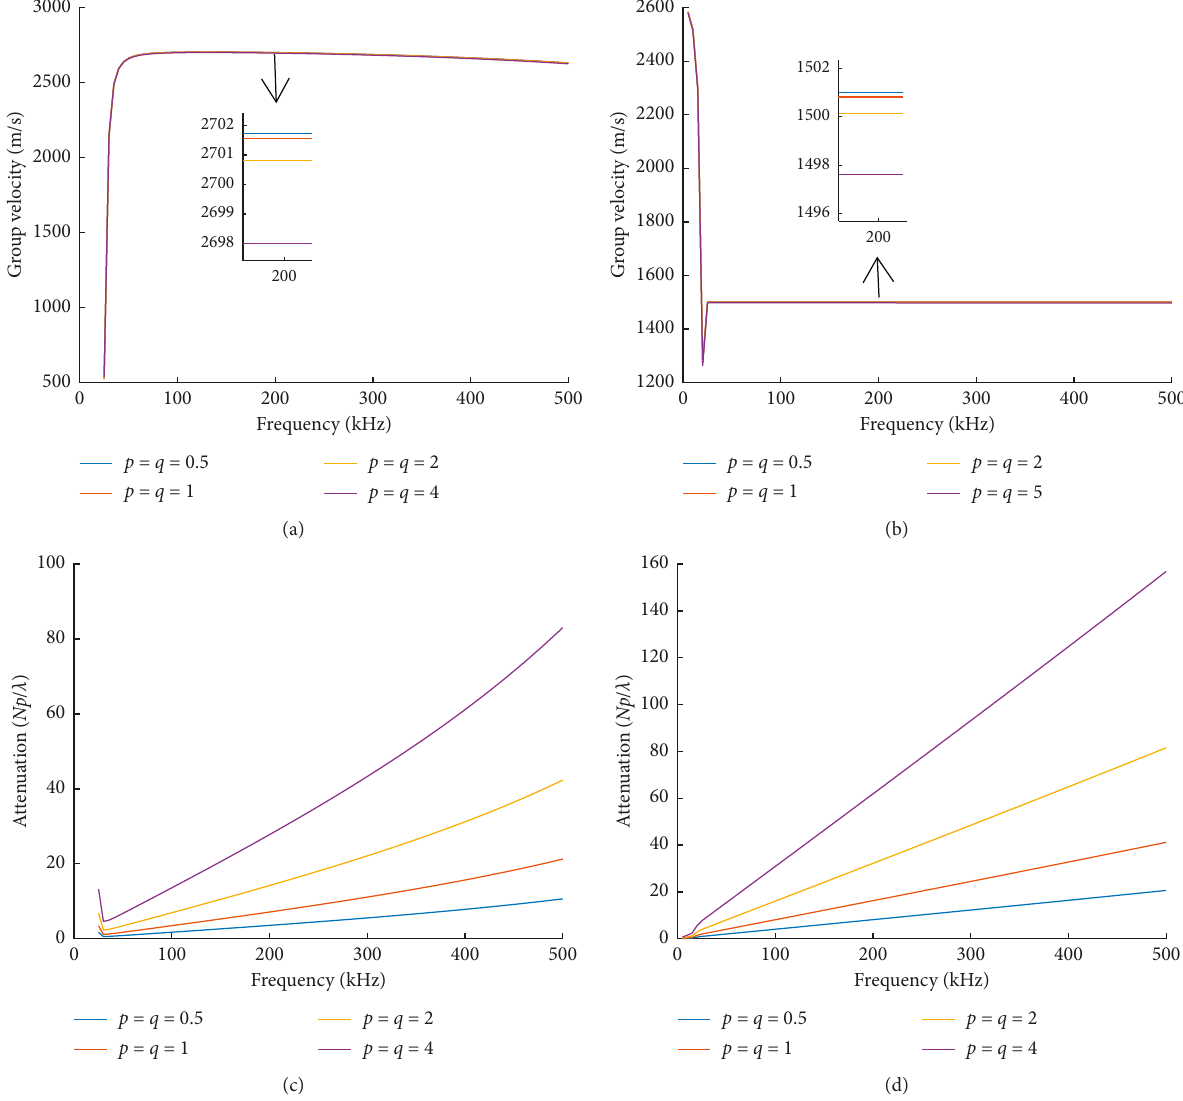
Figure 4: Group velocity and attenuation curves of the guided wave, p � q � 0.5, 1, 2, and 4. (a) Group velocity curves of L ( 0 , 2 ) . (b) Group velocity curves of T ( 0 , 1 ) . (c) Attenuation curves of L ( 0 , 2 ) . (d) Attenuation curves of T ( 0 , 1 )